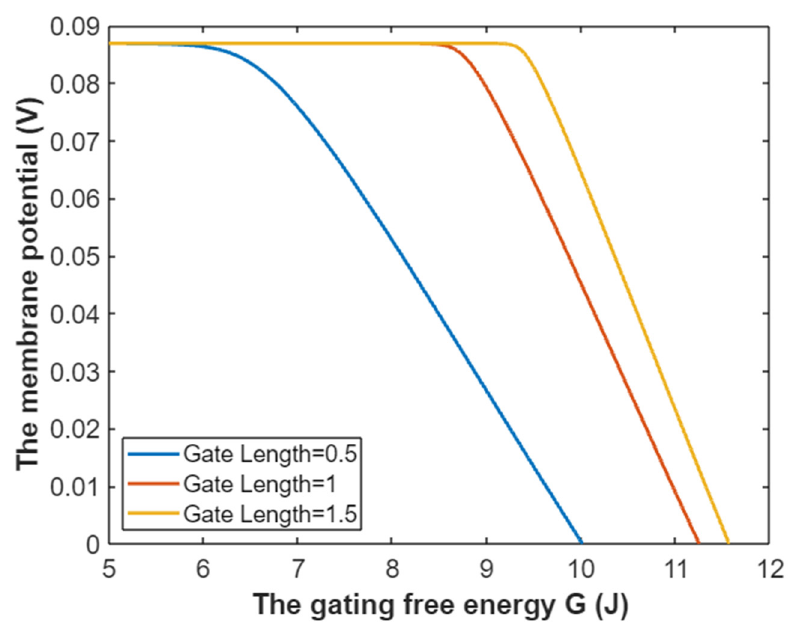
Figure 33. The relationship between gating free energy and the resting membrane potential under the influence of quantum tunneling of sodium ions. the influence of quantum tunneling of sodium